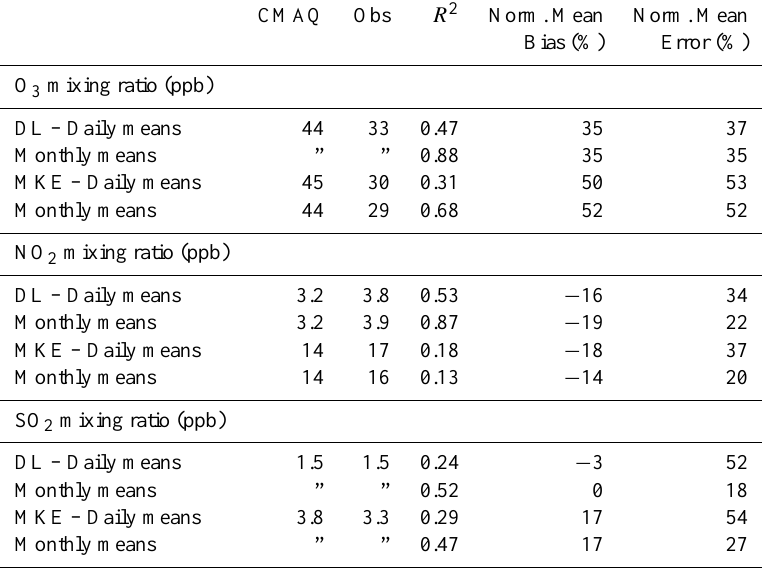
Table A4. Mean values and evaluation metrics are presented to compare CMAQ-Hg with available measurements of O 3 , NO 2 , and SO 2 (at DL and MKE, units ppbv). Equations (1) and (2) used to calculate normalized mean bias and error. Observations were obtained from the US EPA Air Quality System database (http://www.epa.gov/ttn/airs/aqsdatamart/). 2003 daily average observations were compared with daily average values from the lowest model layer of CMAQ-Hg in the corresponding grid cell. For DL, there was only one AQS monitor in proximity (WI site #7). For the MKE location, there were several AQS monitors within close proximity to the mercury/Tekran site, so we chose the monitor in the same model grid cell (WI site #26). Daily average measurements were available year-round for O 3 at DL, and for SO 2 at both sites. Ozone at MKE was available during the summer season (15 April to 16 October). Nitrogen dioxide was available at MKE from 23 May onward and at DL from 27 March onward, continuing at both sites through the end of the